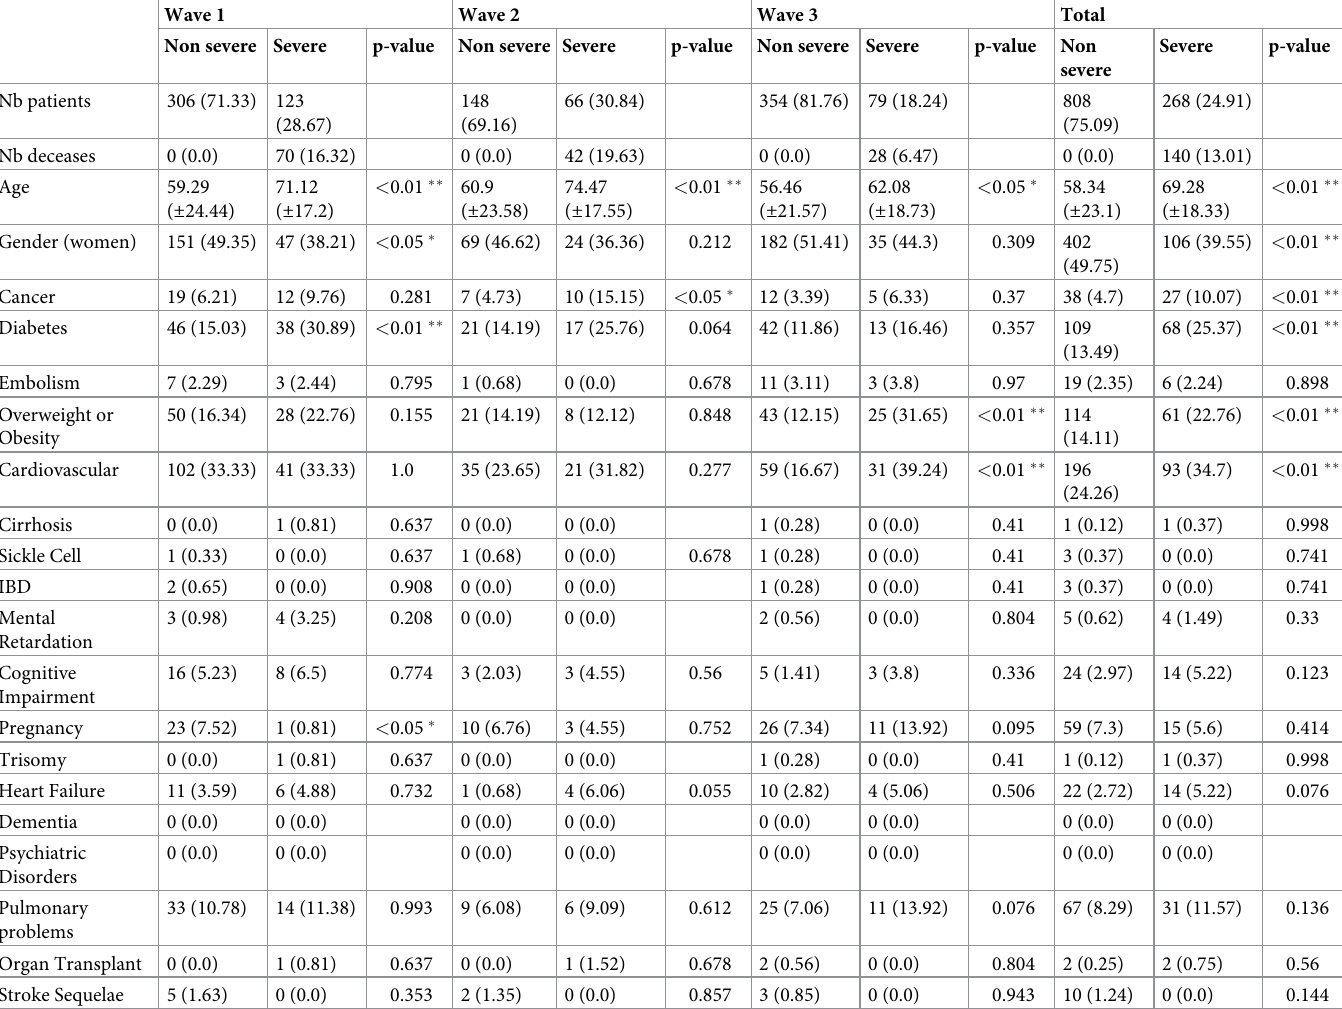
Table 2. Numbers of patients and results of statistical differences between non-severe and severe cases per